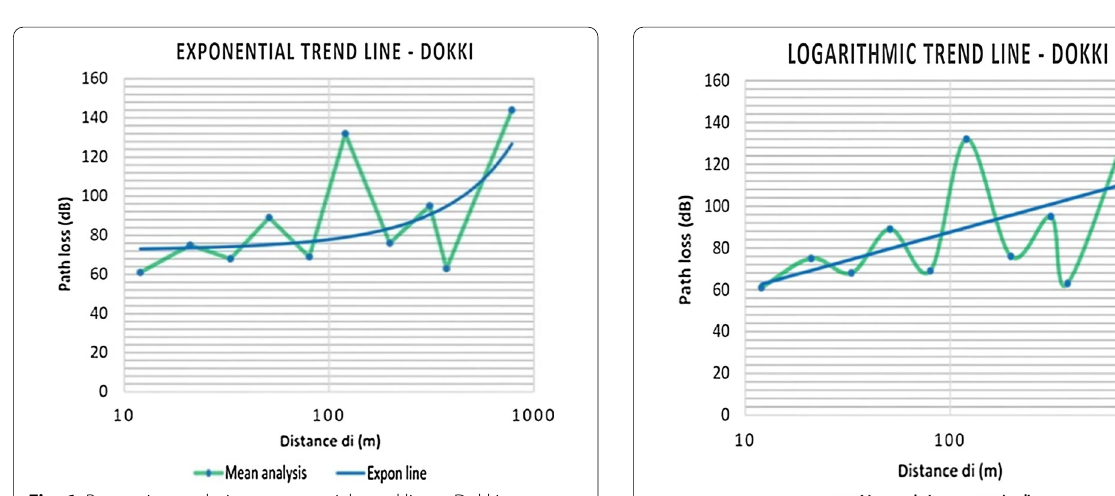
Fig. 6 Regression analysis—exponential trend line—Dokki